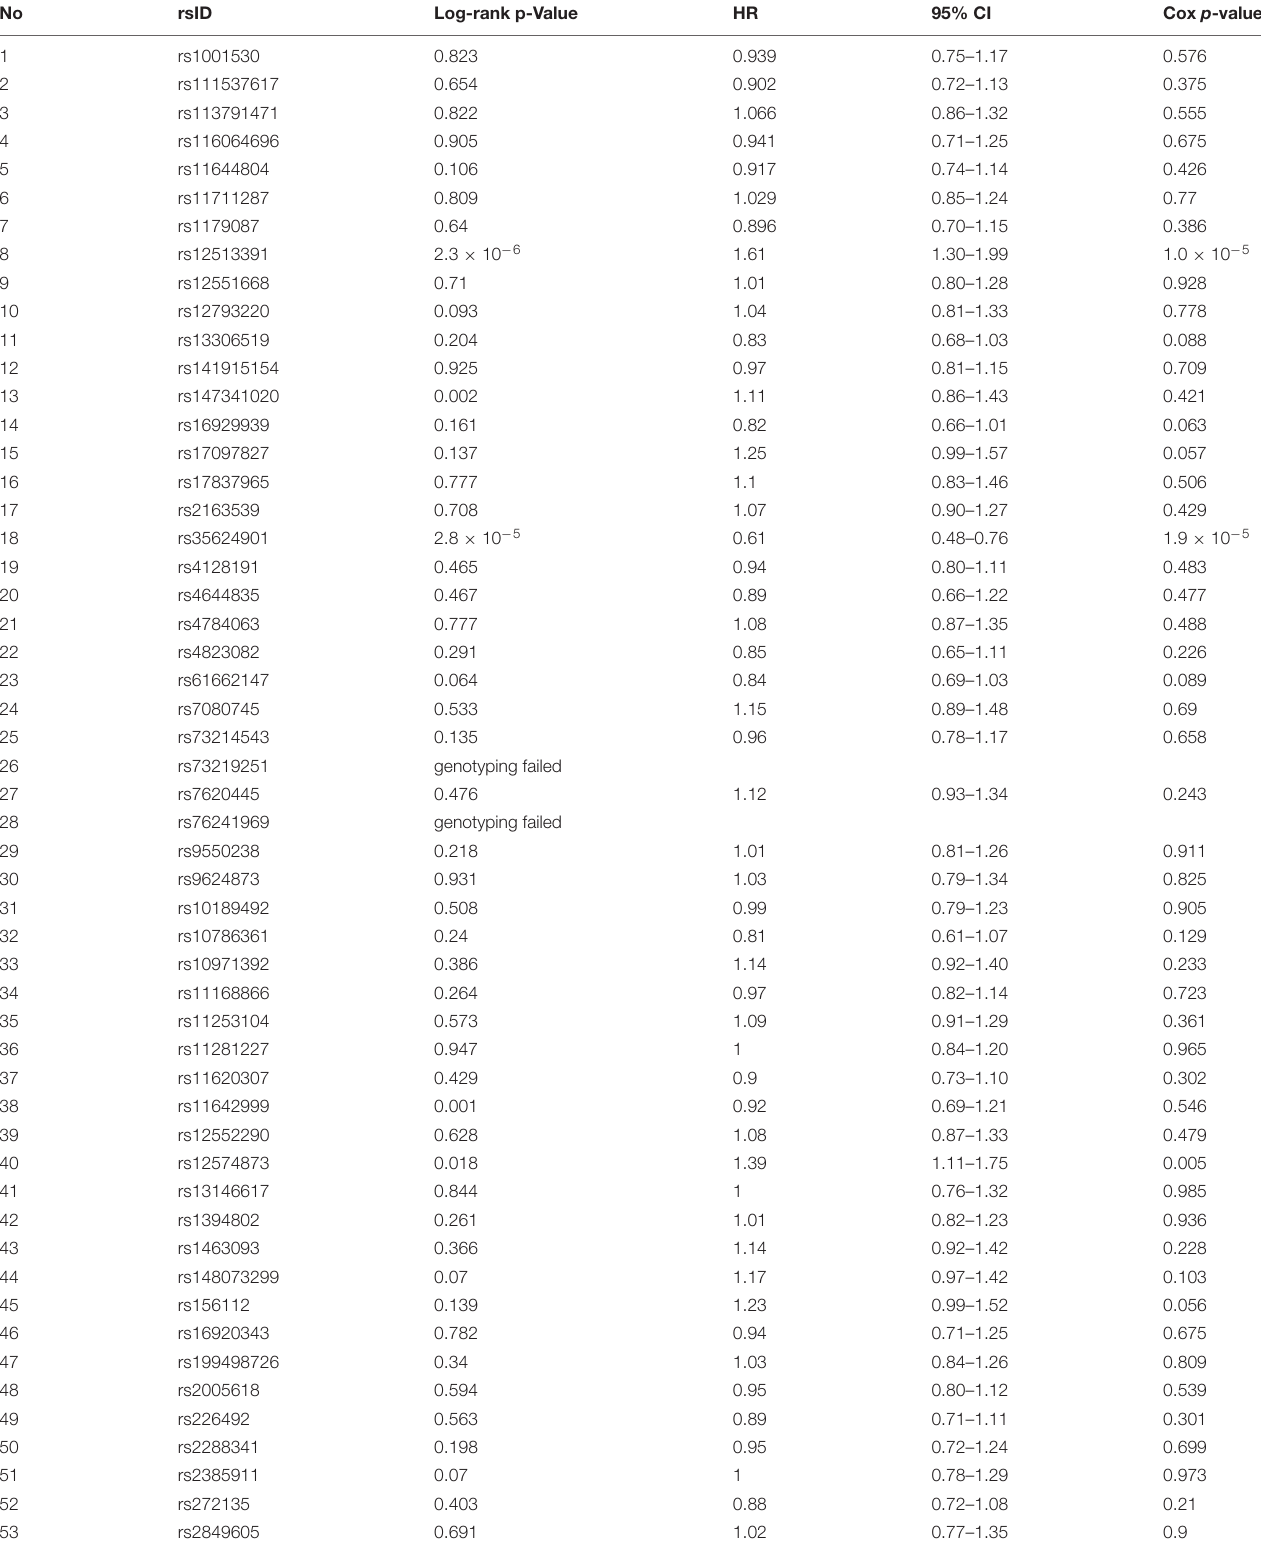
TABLE 1 | Log-rank and Cox-regression analyses of 60 PancanQTL-identified candidate genetic variants for OS in the Jiangsu